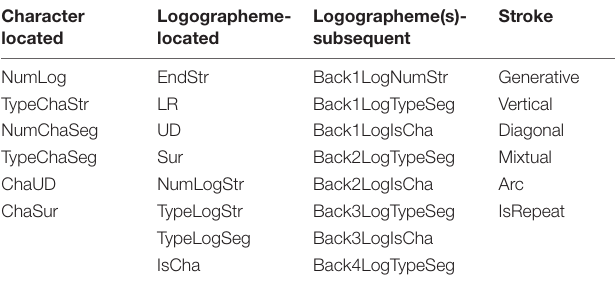
TABLE 3 | The predictor variables in the regression analyses.